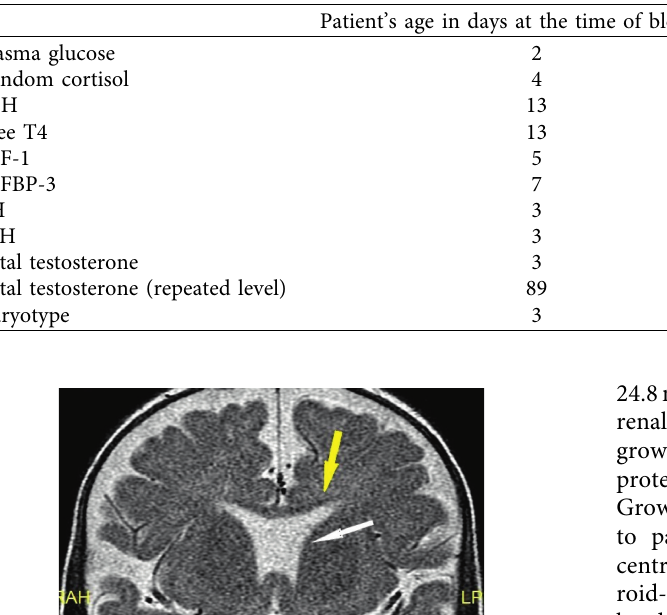
Table 1: Pertinent laboratory findings.